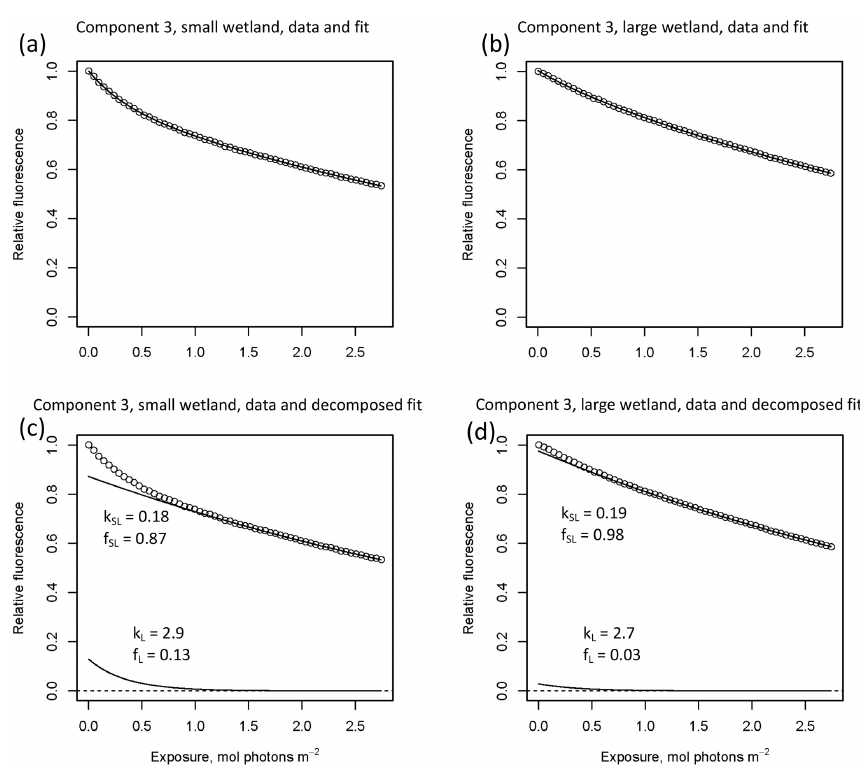
Figure 10. Data and model fit of PARAFAC component three loss in experiments with two wetland samples collected October 2017. Panels (a, b) show data and model fit (Eq. 3) while panels (c, d) decompose the fitted model into its two summed terms, f L e − k L P and f SL e − k SL P , or labile and semilabile terms. (a) Data and fit for small wetland, (b) data and fit for large wetland, (c) data and decomposed model for small wetland, and (d) data and decomposed model for large wetland.